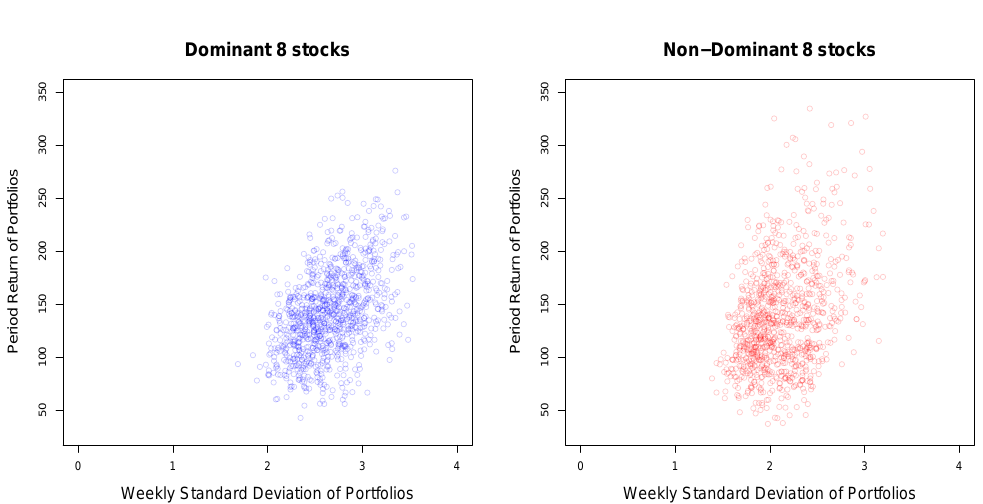
Figure 8. Scatter plots of Period 3 returns against the weekly volatility for the eight-stock portfolios selected on the basis of the clusters identified in neighbor-Nets splits graph from Period 2 with the clusters split into dominant and non-dominant industry